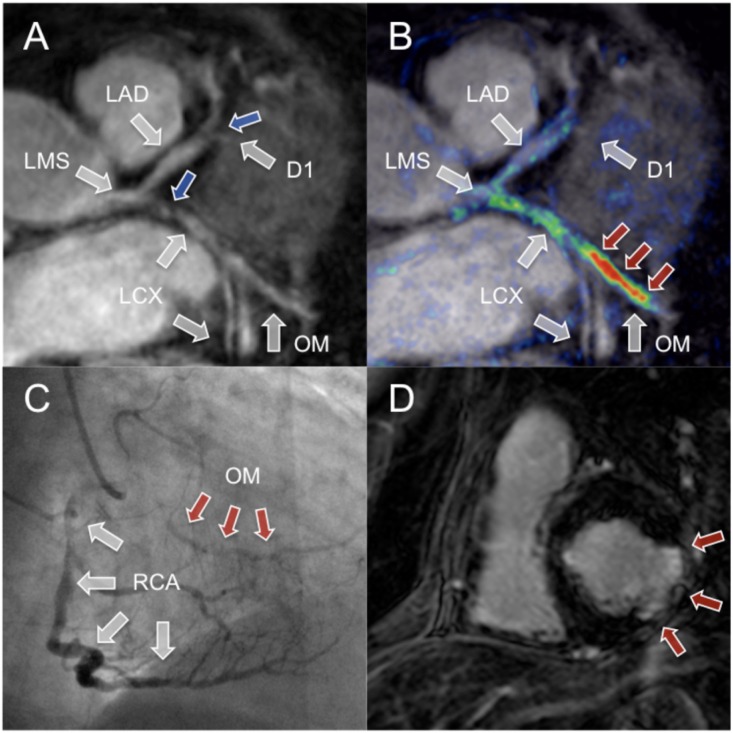
CE-MRCVI findings with troponin positive ACS in the LCX.Coronary MRA (A) with troponin positive ACS showed decreased vessel lumen size of the proximal LCX and first marginal branch (grey arrows). To highlight the relationship between and morphology (A) and CE-MRCVI, images were fused in a way similar to PET/CT (B). CE-MRCVI displays high signal intensity (red arrows) within the first marginal branch. Corresponding XCA (C) confirmed CE-MRCVI findings with mid LCX lesion. Short axis delayed enhancement scan shows predominantly transmural myocardial infarction of the mid-ventricular infero-lateral segment. MRA: magnetic resonance angiography, CE-MRCVI: contrast enhanced magnetic resonance coronary vessel wall imaging, PET/CT: positron emission tomography/computed tomography.